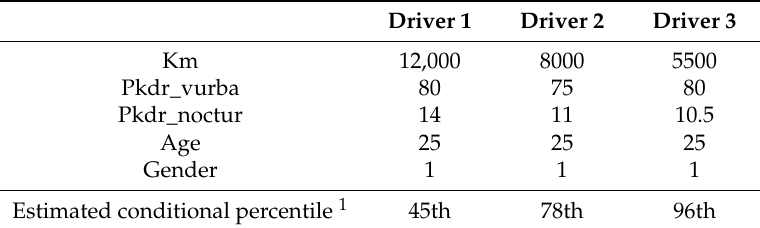
1 The estimated conditional percentile is found by locating the quantile level that produces a response equal to 600 km, given the exogenous characteristics (total kilometers driven, percent urban driving, percent nighttime driving, age and gender) in the three example